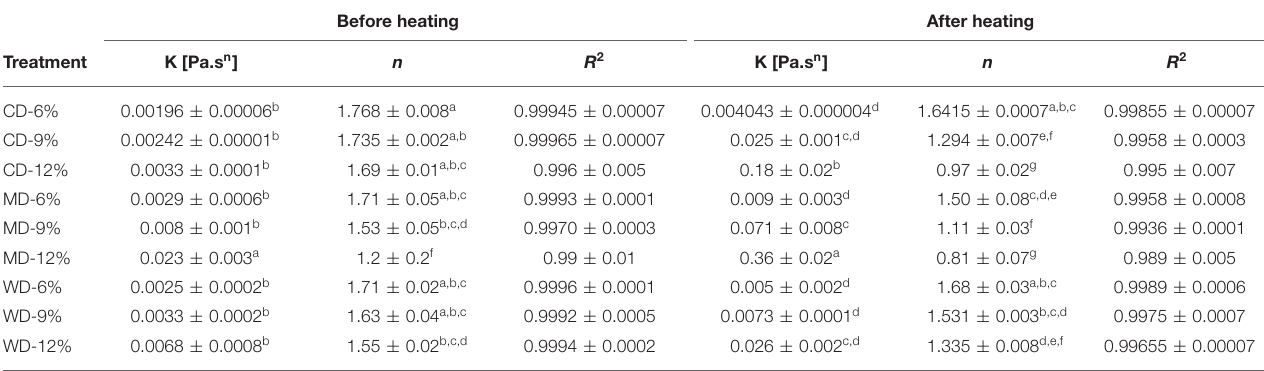
TABLE 1 | Flow properties of hyperprotein flour-added dispersions before and after heat treatment. Before heating After heating Treatment